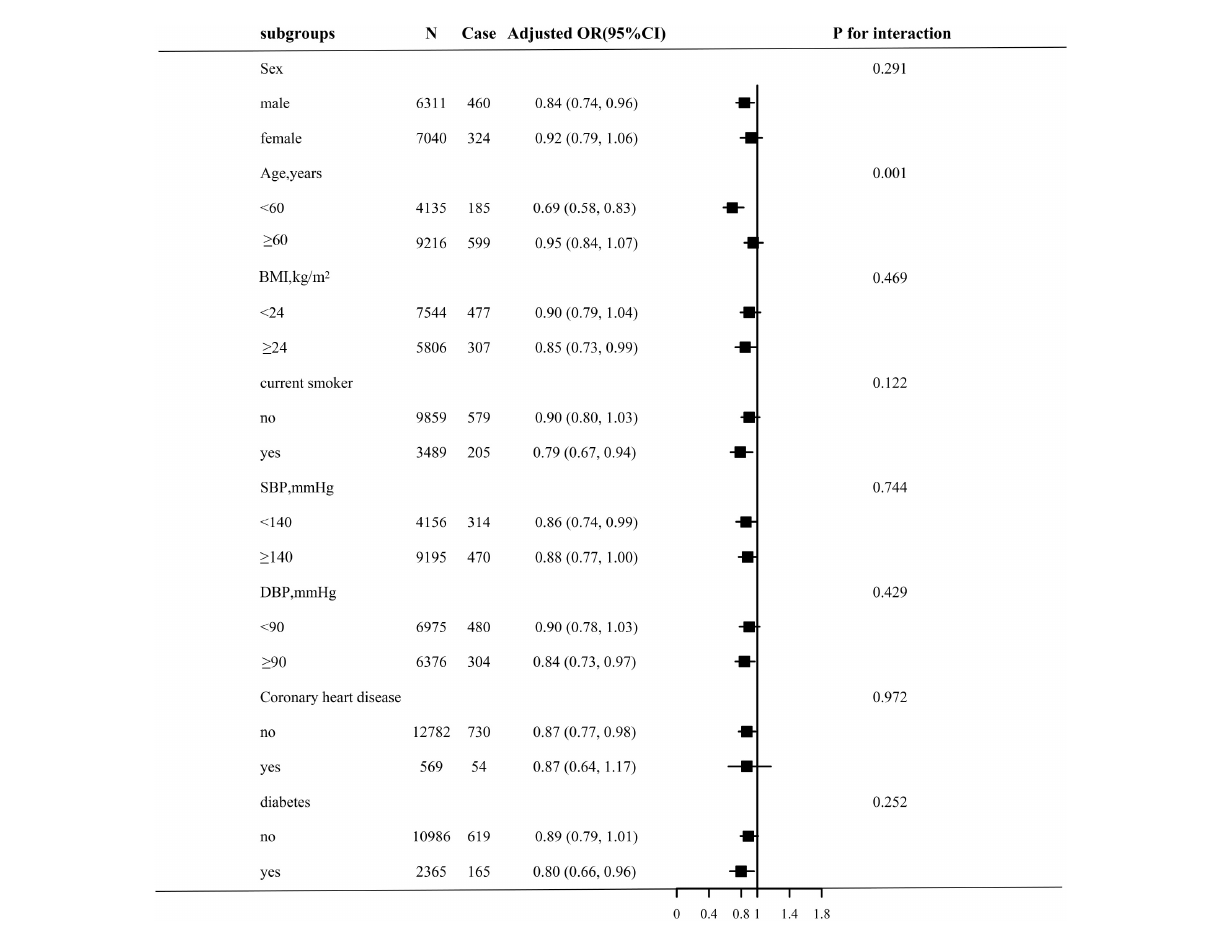
FIGURE2 Stratified Analyses by potential modifiers of the association between TCBI and the prevalence of stroke. Each subgroup analysis adjusted for age, sex, BMI, SBP, DBP, current smoking, current drinking, diabetes, antihypertensive drugs, antidiabetes agents, antiplatelet drug, Hcy, FPG, HDL-C, LDL-C, SUA, eGFR, and except for the stratifying